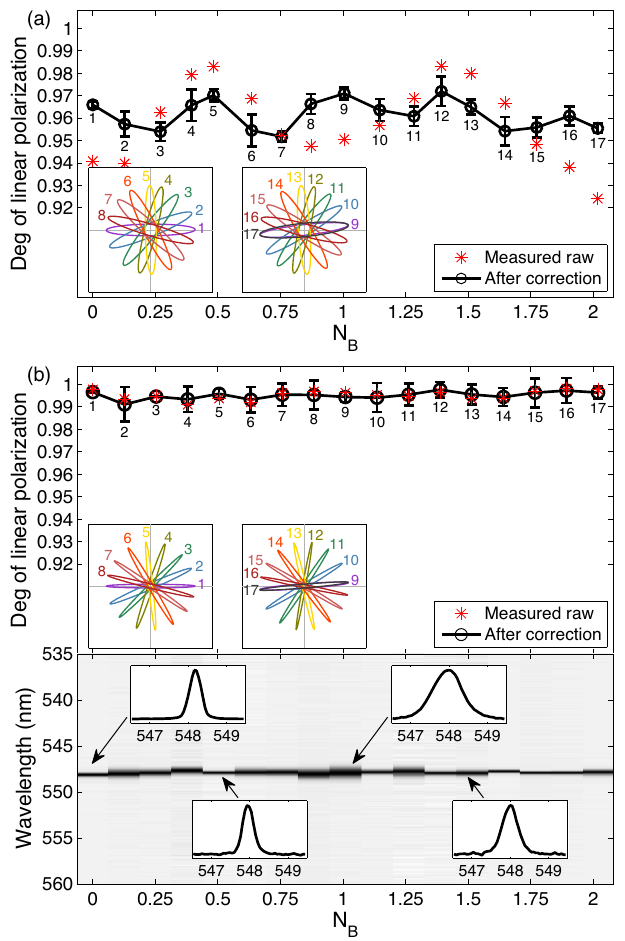
FIG. 4. Degree of FEL beam linear polarization P using (a) the prototype and (b) the new FEL polarimeter. The polarization angle is rotated by tuning buncher setting N insets show the measured FEL polarization ellipses. All mea- surements are indexed by a number from 1 to 17. In (a), the storage ring is operated with a single-bunch electron beam at an energy of 550 MeVand beam current of about 45 mA. The FEL is lasing at about 547.8 nm with an FEL detuning of about 7 × 10 − 7 . In (b), a 533 MeV single-bunch electron beam is used with a beam current of about 30 mA. The FEL is operated with zero detuning. The lower part of (b) shows the measured spectra of the FEL beam with their maximum intensity scaled to unity. The measured FEL central wavelength is 547 . 94 (cid:2) 0 . 093 nm, and the measured average rms spectral width is 0.25 nm with an rms variation of 0.066 nm. Note that the dataset shown in (b) is different from the one reported in Ref.